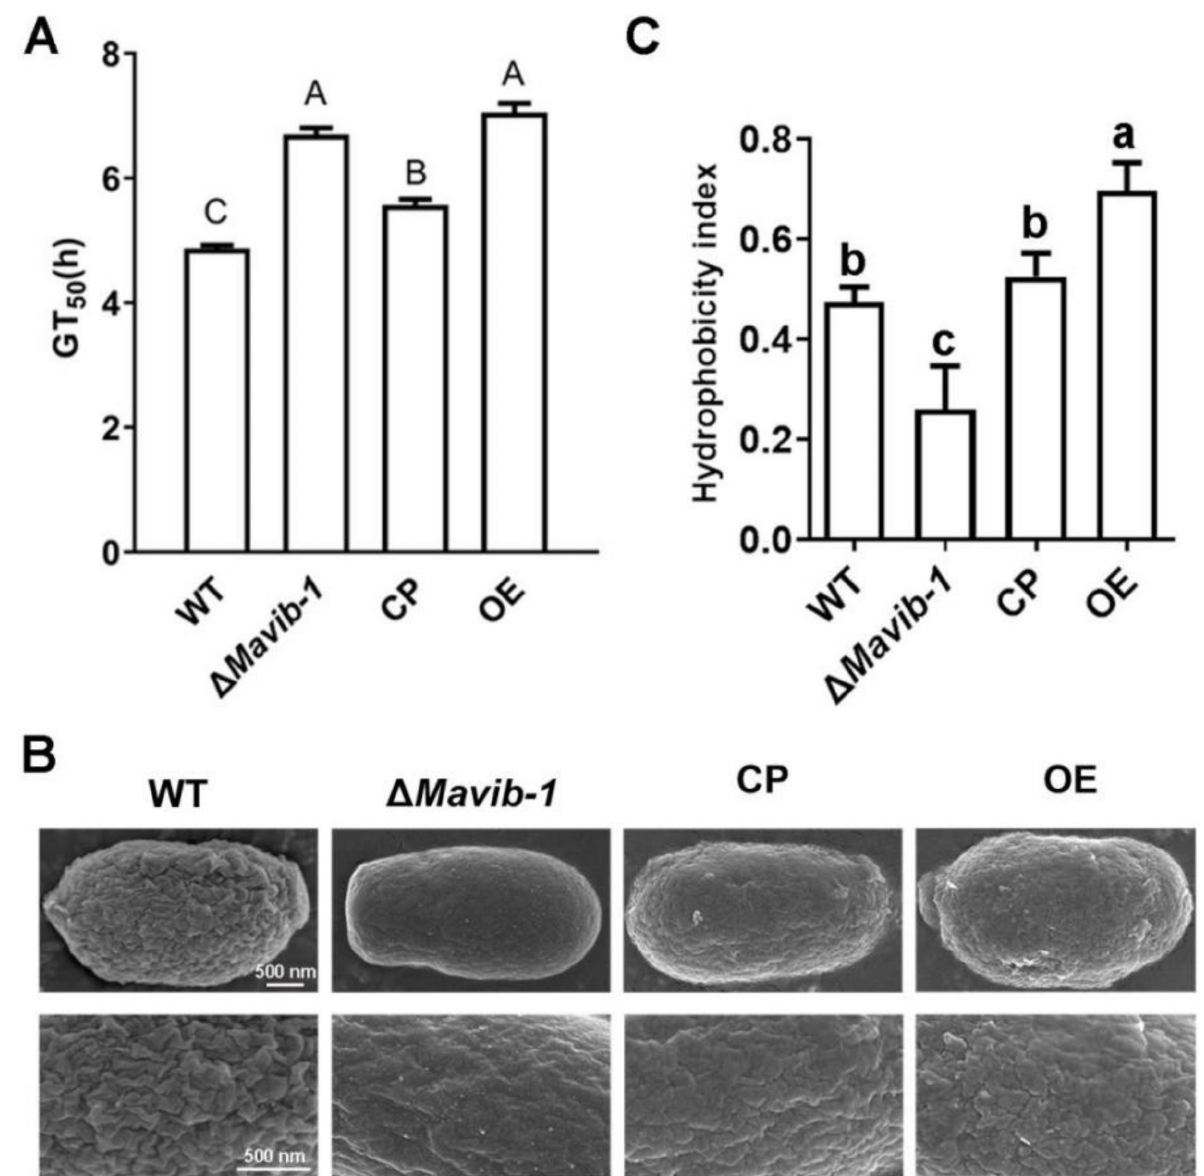
Figure 3. Conidial germination, conidial surface morphology and hydrophobicity determination. ( A ) The 50% germination times (GT 50 ) of WT, ∆ Mavib-1 , CP and OE strains. ( B ) The conidial surface morphology by SEM. ( C ) Conidial hydrophobicity index. The trial was repeated three times. Different capital letters represented significant difference at p < 0.01 and different lower-case letters indicate significant difference, p <